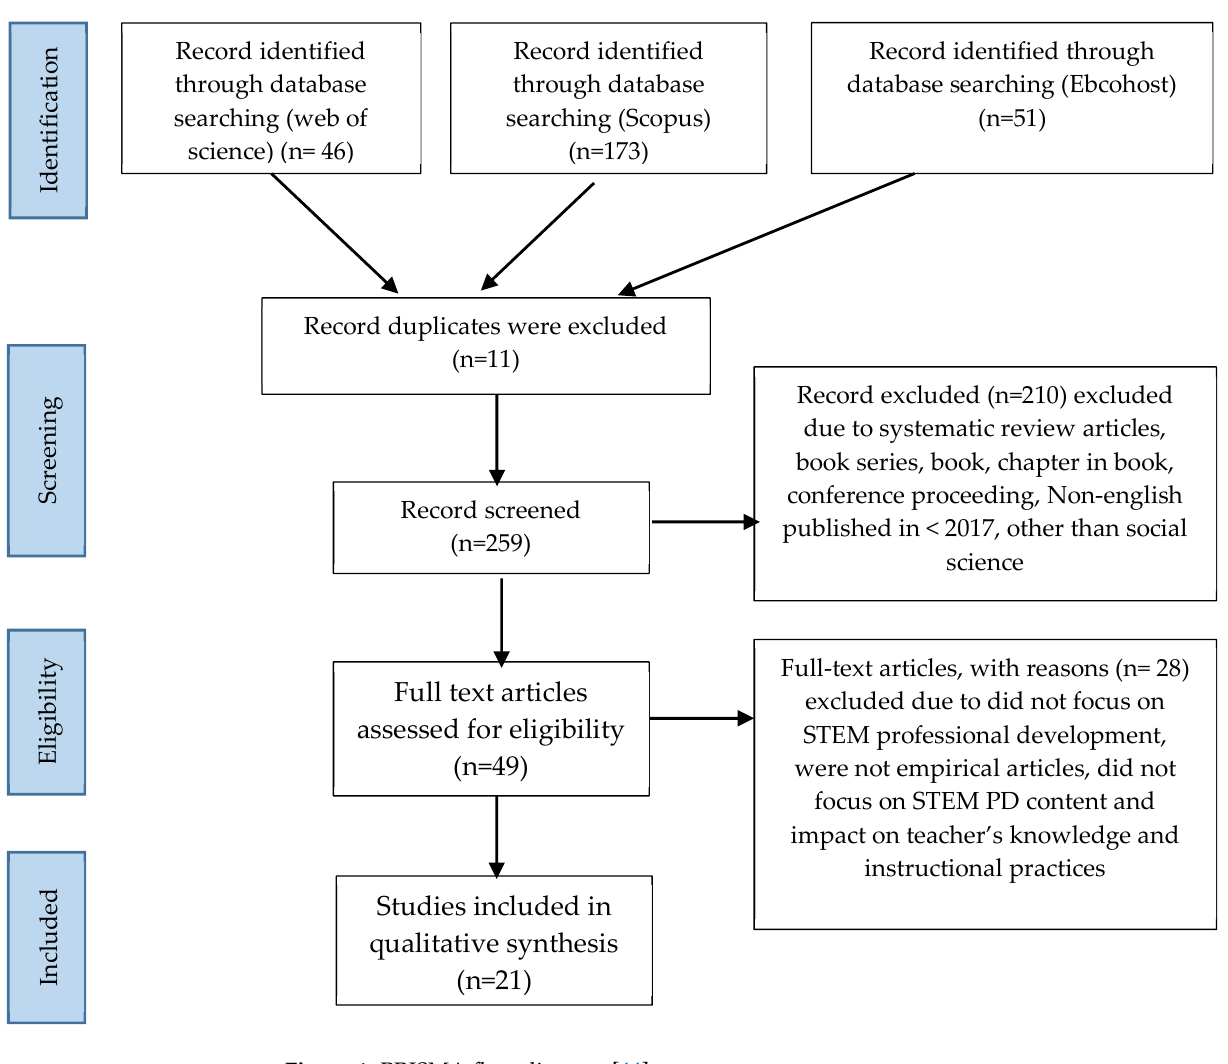
Figure 1. PRISMA flow diagram [44]. Table 1. The search